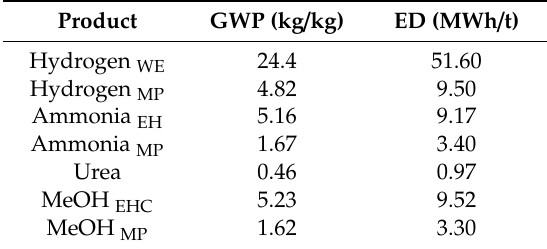
Table 1. Emissions and energy demand of chemical products. Global warming potential (GWP) and energy demand (ED) are derived from electricity demand. The data source used to construct the table can be found in [14]. Abbreviations: water electrolysis (WE), methanol pyrolysis (MP), electrolysis hydrogen (EH), electrolysis hydrogen and carbon dioxide